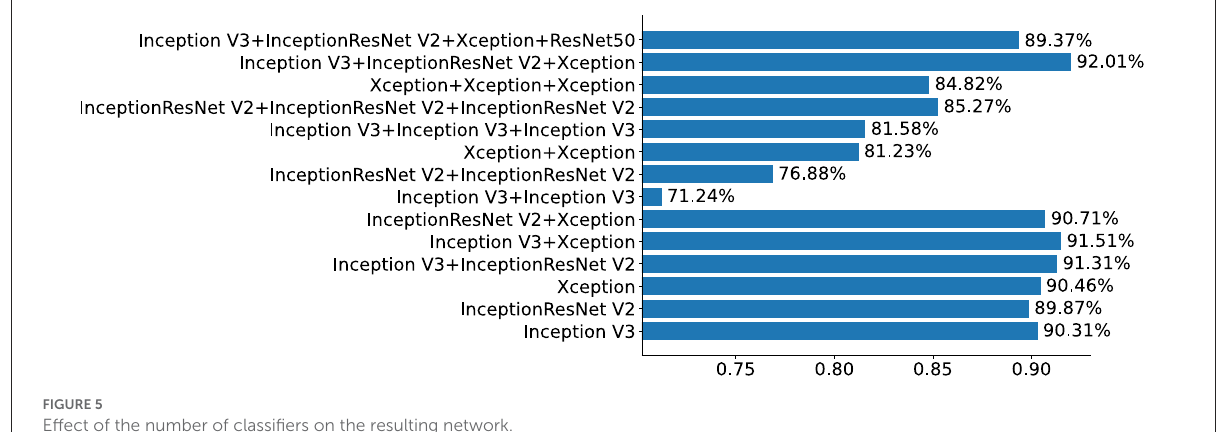
FIGURE5 Effect of the number of classifiers on the resulting network.